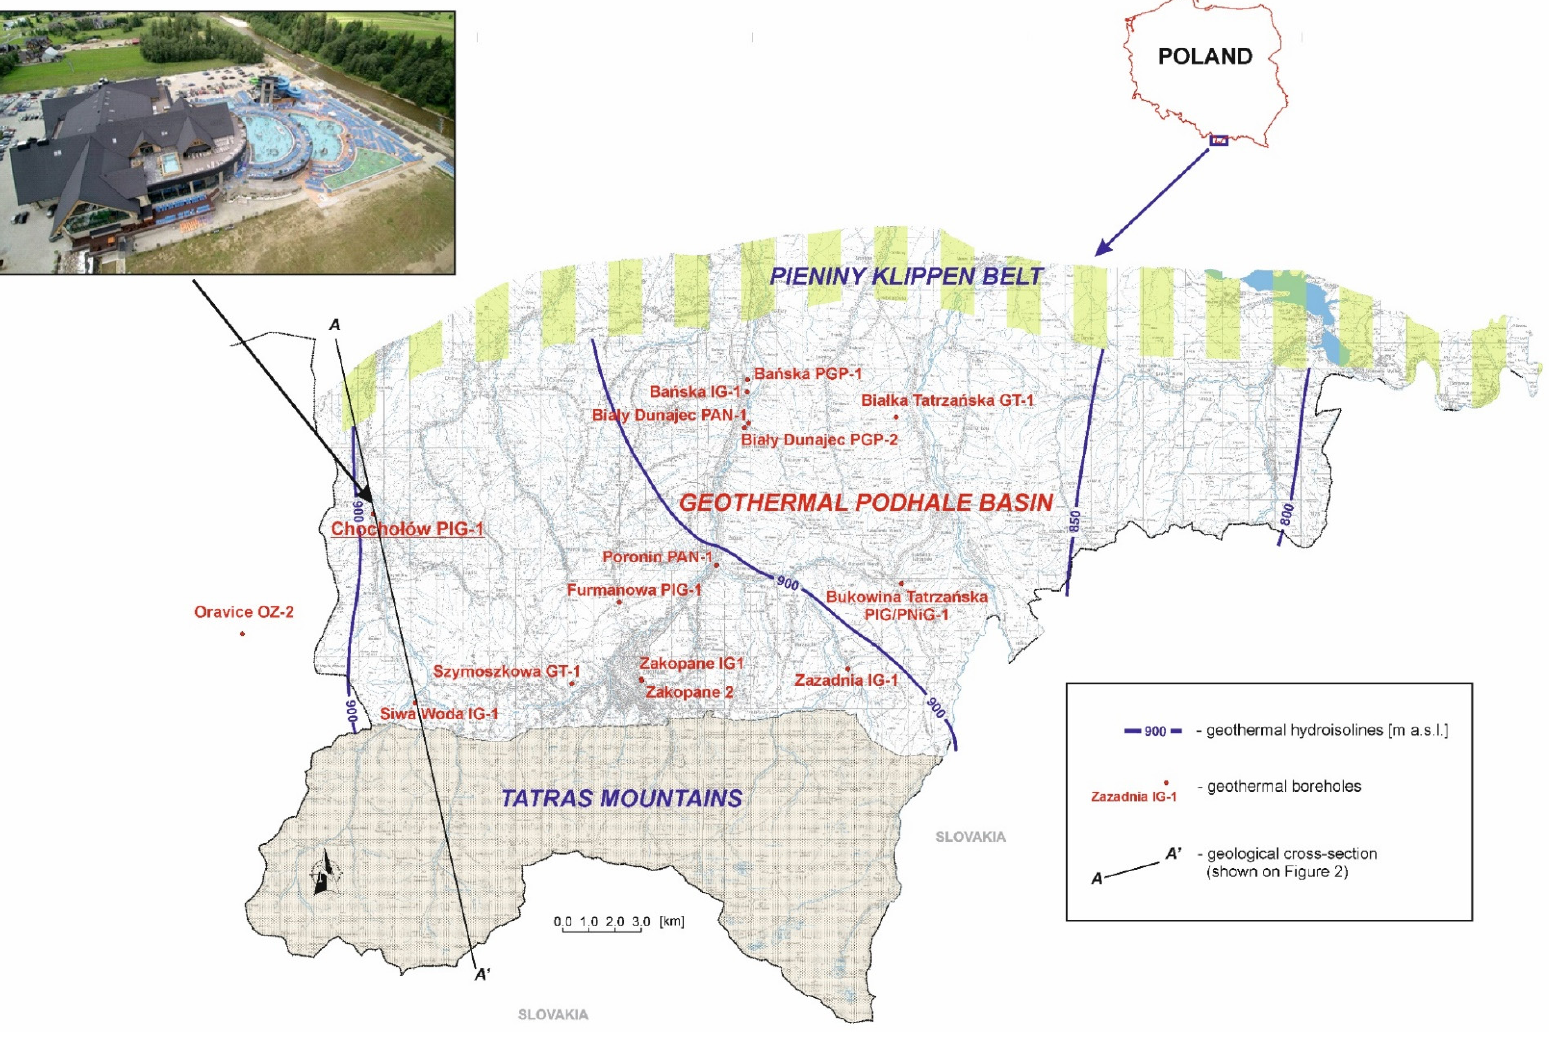
Figure 1. Chocho ł owskie Termy geothermal complex against the background of the geothermal Podhale Basin.